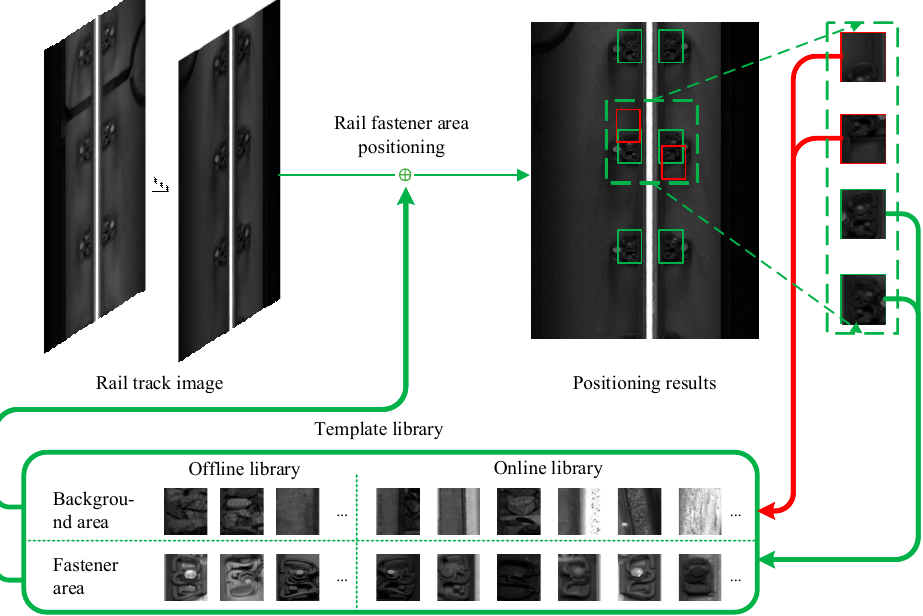
Figure 5. Update process of online template library.